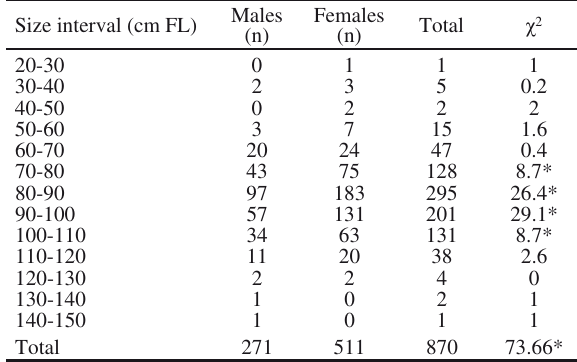
Table 3. – Sex ratio by size interval of males and females of dol- phinfish, Coryphaena hippurus , and results of the chi-square ( χ 2